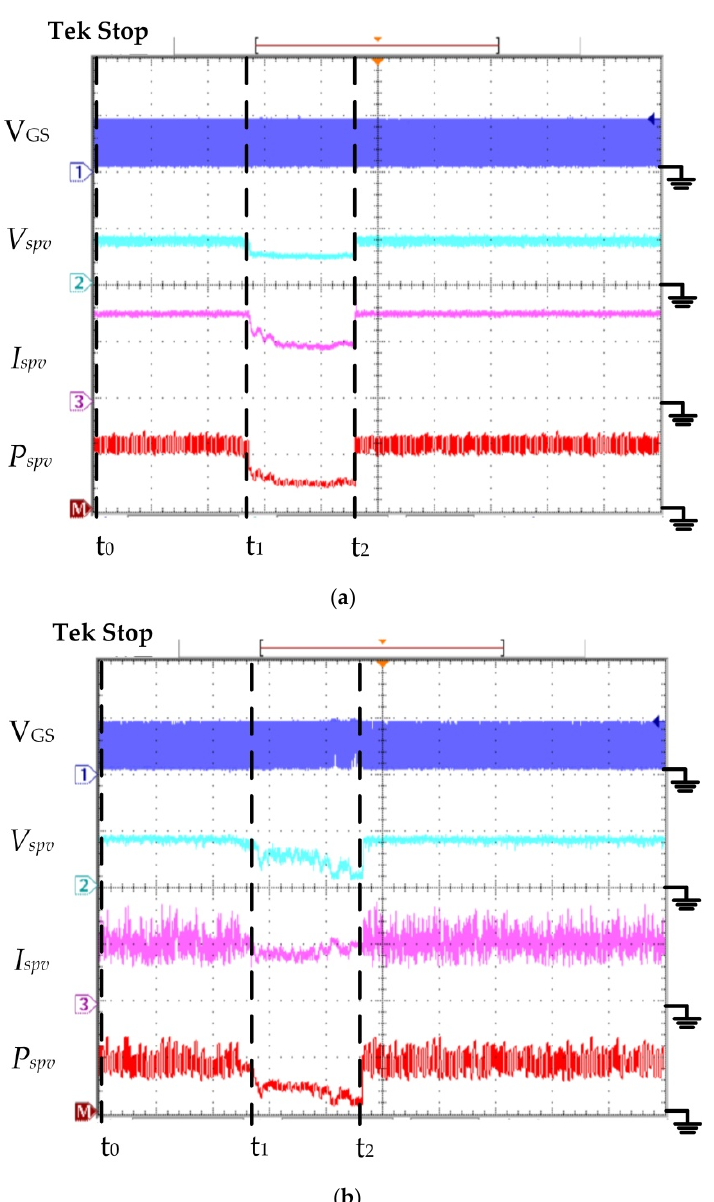
Figure 9. V GS , V spv , I spv and P spv waveforms for a SPV module under a T of 25 °C and partial shading conditions: ( a ) the proposed algorithm and ( b ) the P&O algorithm. (V GS : 20 V/div; V spv : 10 V/div;